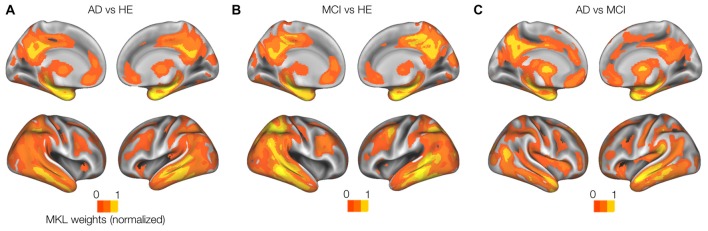
Weight (per region) maps modeled by multi-kernel learning (MKL) using GM-MRI data. Rendered MKL weights on a template. The results from a single modality GM-MRI data with an average of 75% contribution to (A) AD-vs.-HE, (B) MCI-vs.-HE and (C) AD-vs.-MCI classification problems. Weights for PiB-PET with lower (25% or less) contribution are not shown.